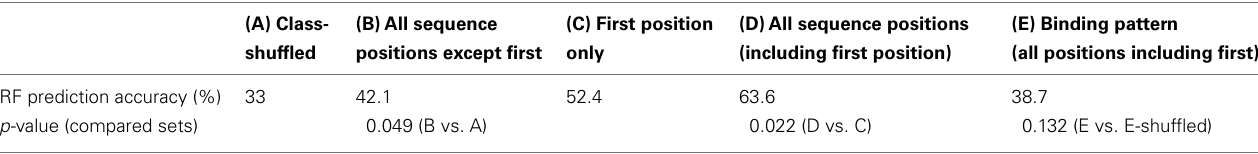
Table 2 |Accuracy of Random Forest predictions for the sorting of miRNAs from the Confidence Set to eitherAGO1, 2, or